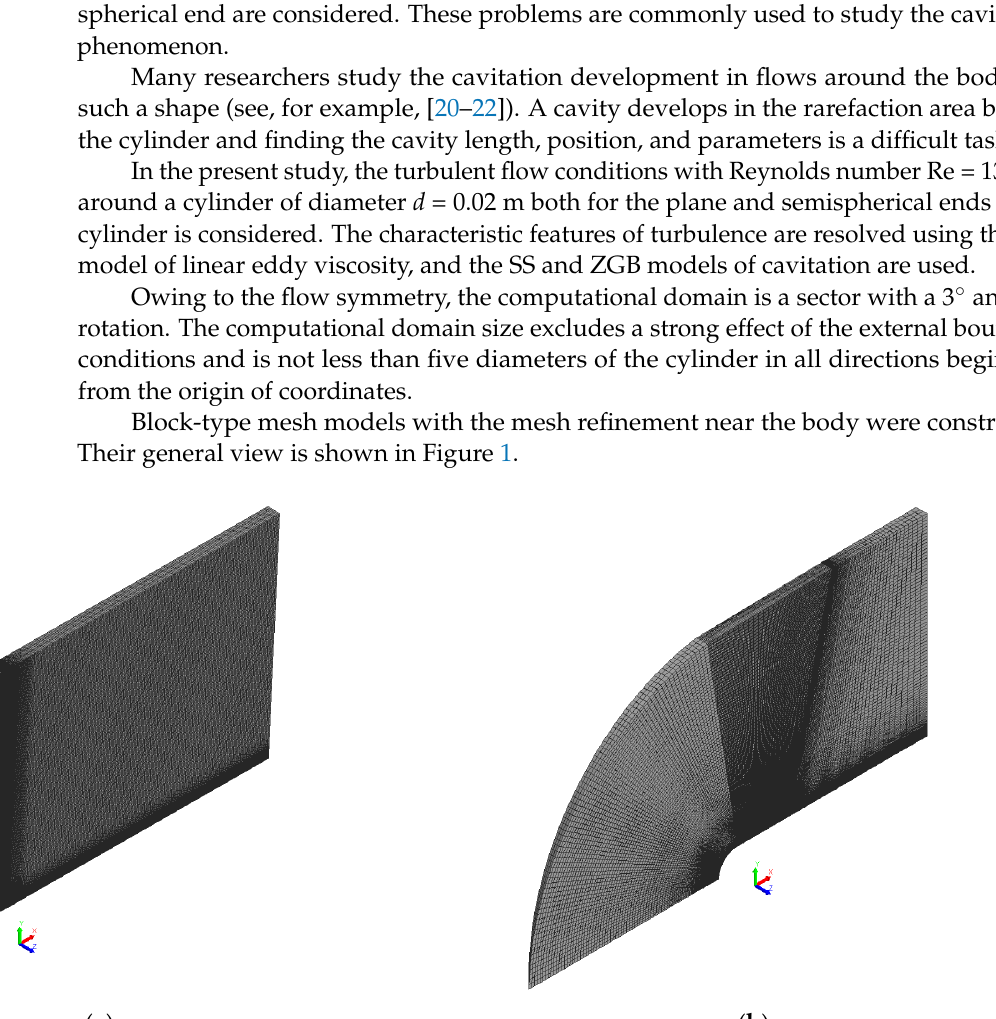
Table 1. The mesh model